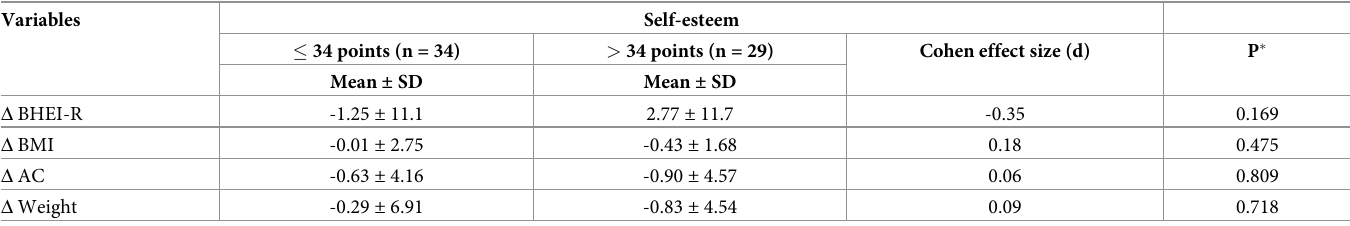
Table 9. Classification of self-esteem (dichotomized at the median) associated with the BHEI-R, BMI, AC and weight of patients with metabolic syndrome, Porto Alegre, Brazil (n = 63). Variables